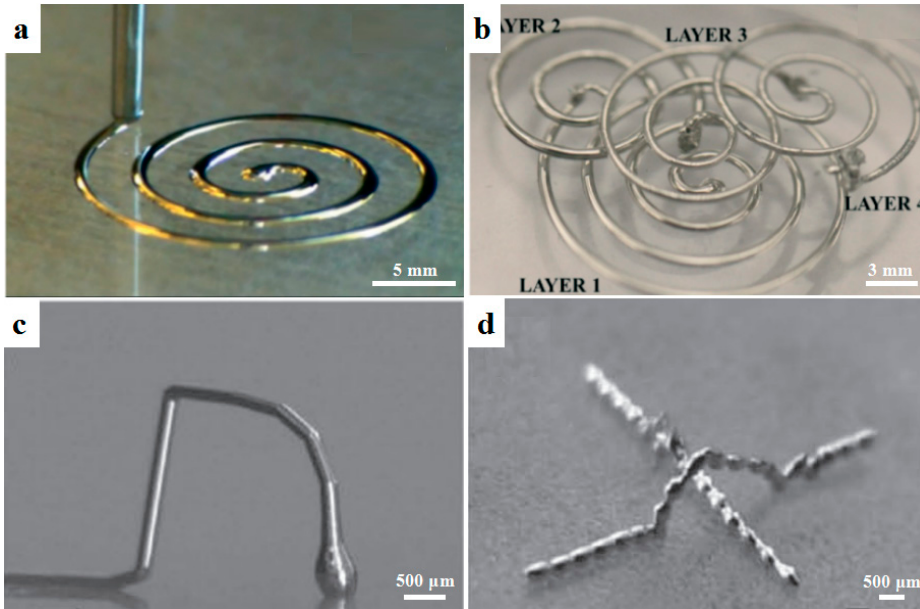
Figure 1. Liquid metals for microscale conductive features. ( a ) Direct printing of EGaIn liquid metal, a eutectic alloy of gallium (Ga) and indium (In) with a melting point of 15.5 °C; ( b ) 3D microfluidic channels with 3D-printed liquid metal as the sacrificial template, reprinted from [24] with the permission of John Wiley and Sons, Copyright 2013; ( c , d ) 3D conductive features directly printed from liquid metals, reprinted from [25] with the permission of John Wiley and Sons, Copyright 2013.